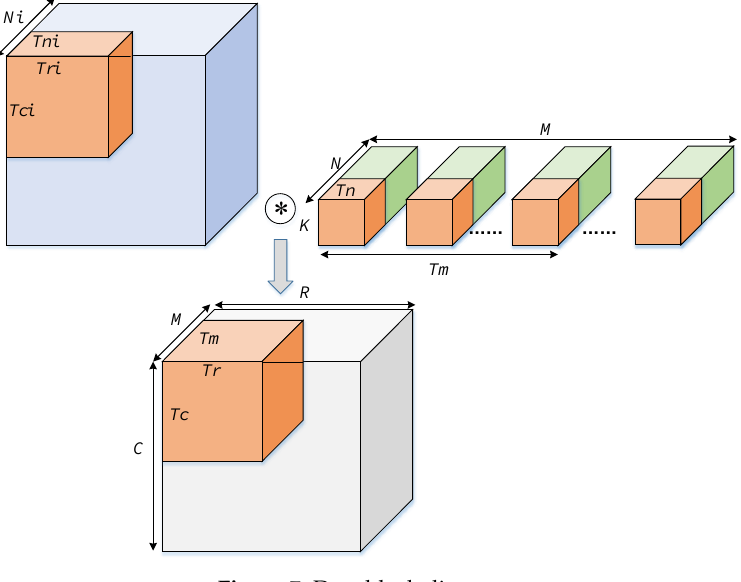
Figure 7. Data block diagram.